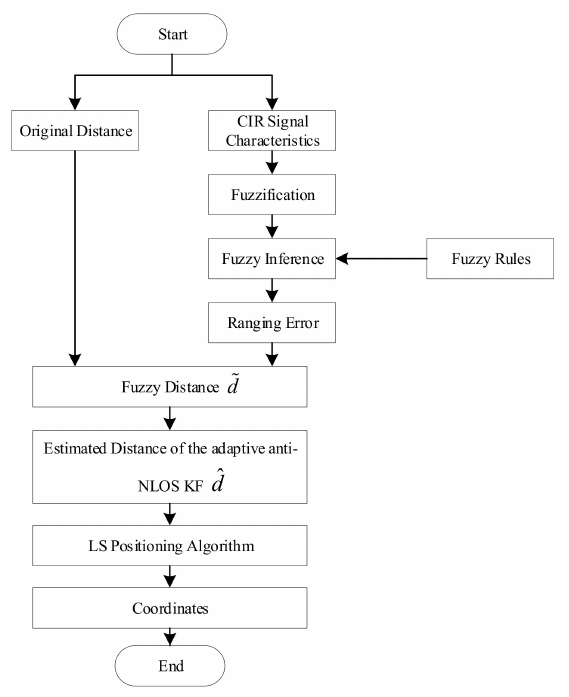
Figure 5. Flow chart of the positioning algorithm combining fuzzy inference with adaptive anti-NLOS